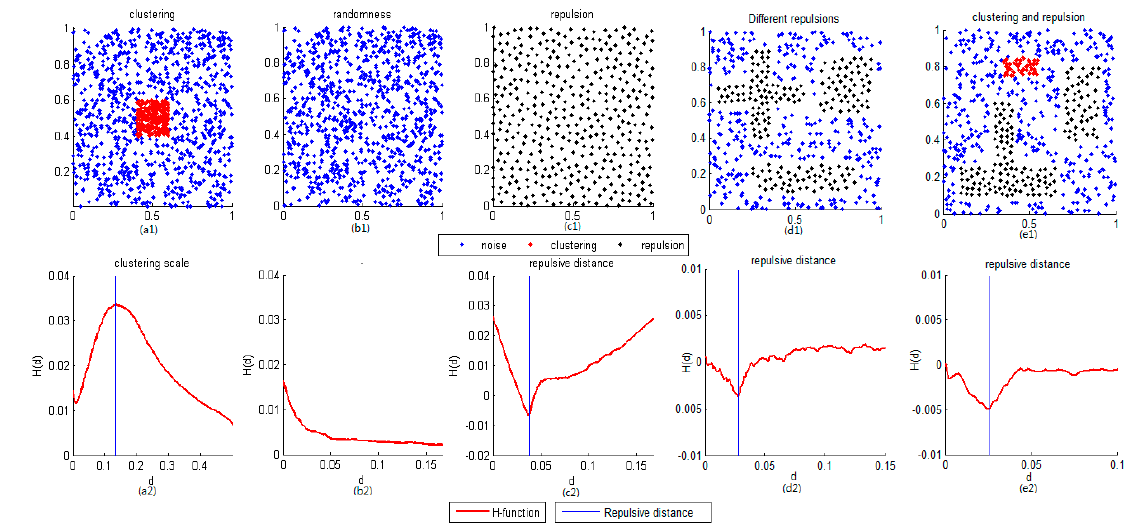
Figure 5. Distributions of different types of point processes and their H-functions. ( a ) Aggregation and noise; ( b ) homogeneous point process; ( c ) repulsion (repulsive distance=0.038); ( d ) repulsion and noise (repulsive distance=0.028); and ( e ) aggregation, repulsion and noise (repulsive distance=0.026).